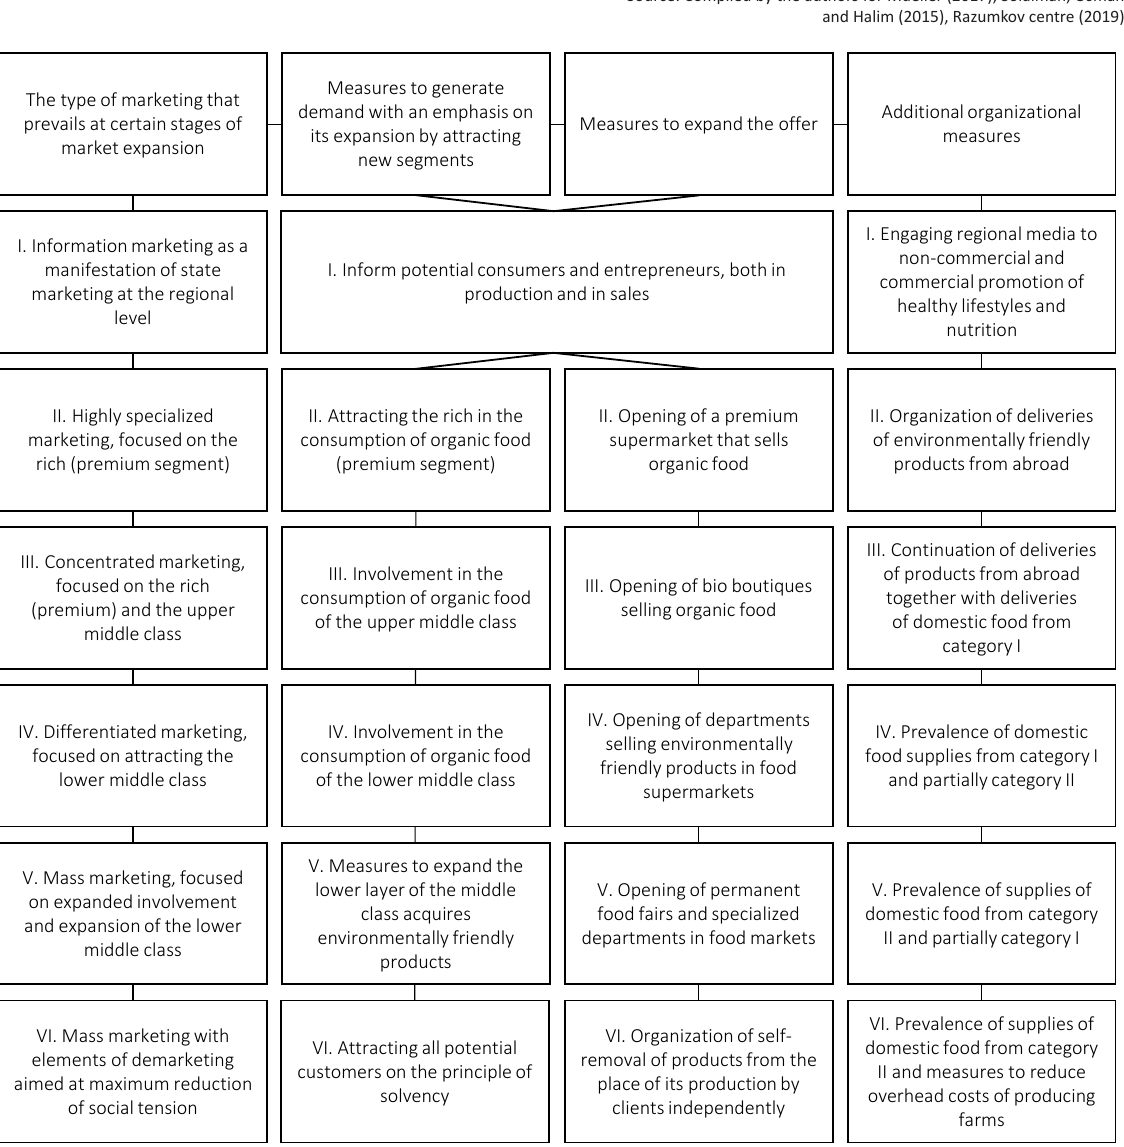
Figure 6. Stages of expanding the market for organic food in the